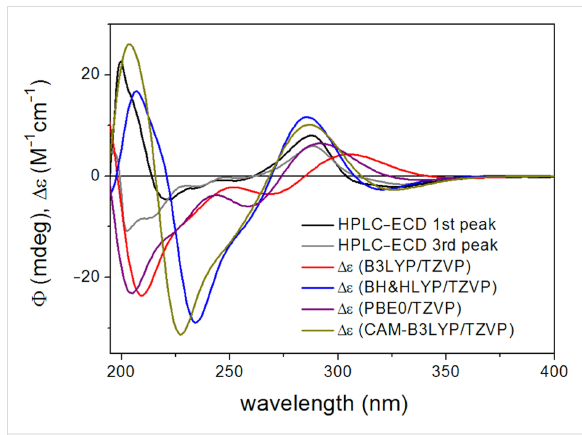
Figure 13: Experimental HPLC-ECD spectra of 3b and 3c compared with the Boltzmann-weighted ECD spectra computed for the CAM- B3LYP/TZVP PCM/MeCN low-energy conformers of (2 R ,5’’ S )- 3 at various levels.